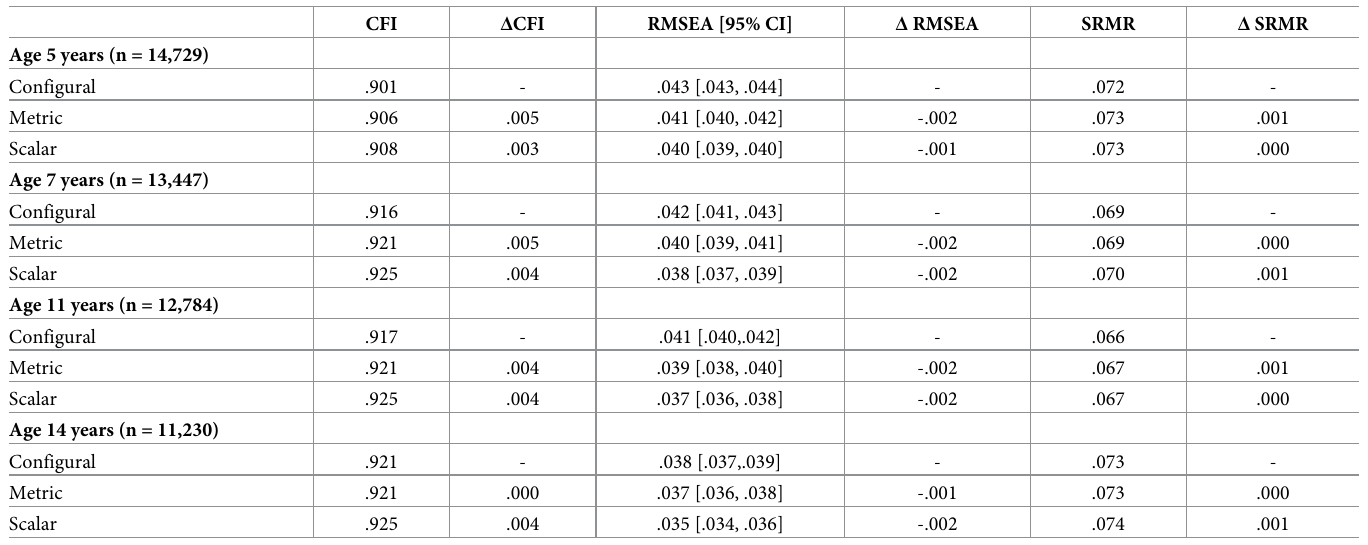
Table 3. Household income measurement invariance